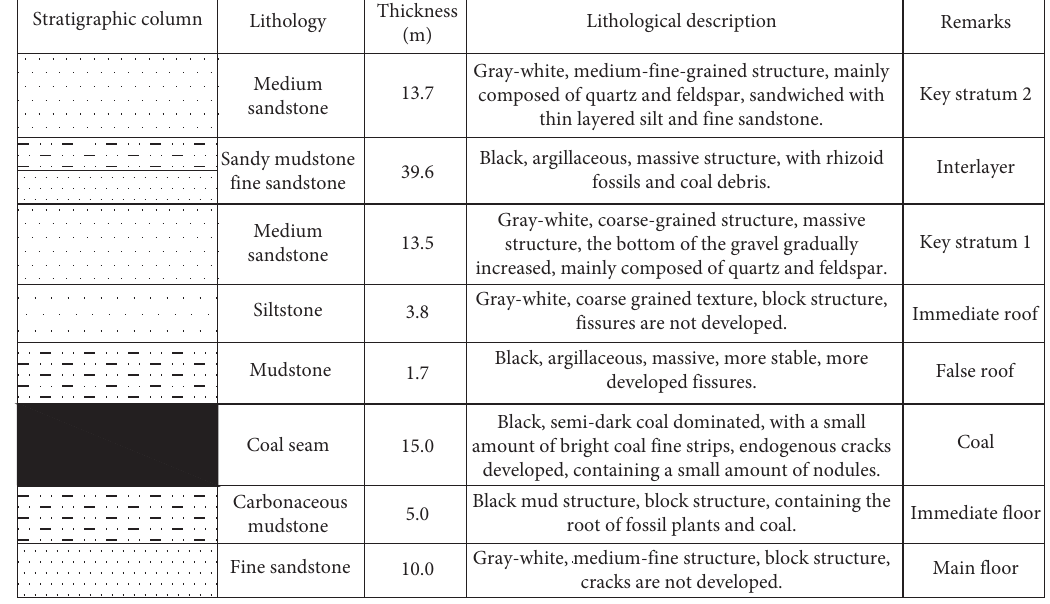
Figure 2: Generalised stratigraphy column of the test site.